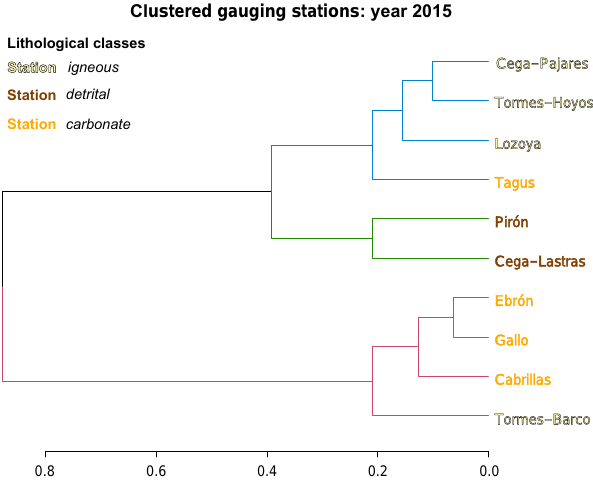
Figure 6. Gauging stations clustered by the current normalized seasonal streamflow regime (agglomerative coefficient, a.c. = 0.81). Stations are grouped by lithological classes.